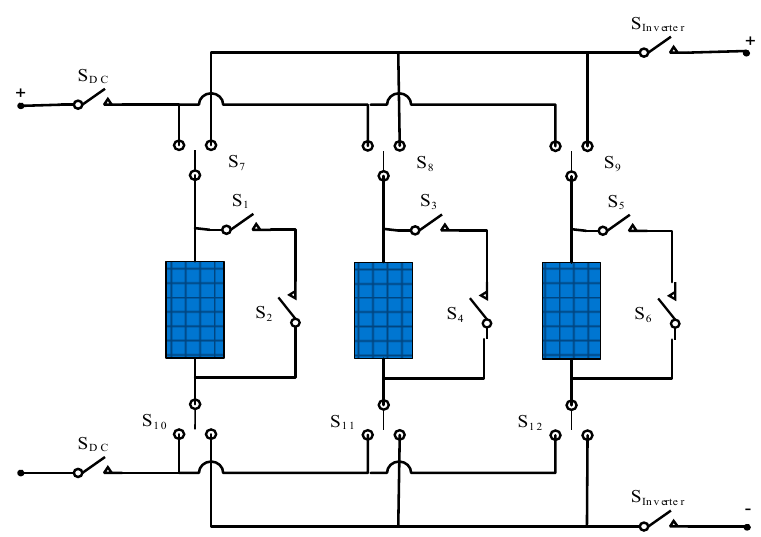
Figure 4. Switching matrix proposed in [25], reproduced from the proceedings of the IECON 2010, IEEE: 2010.